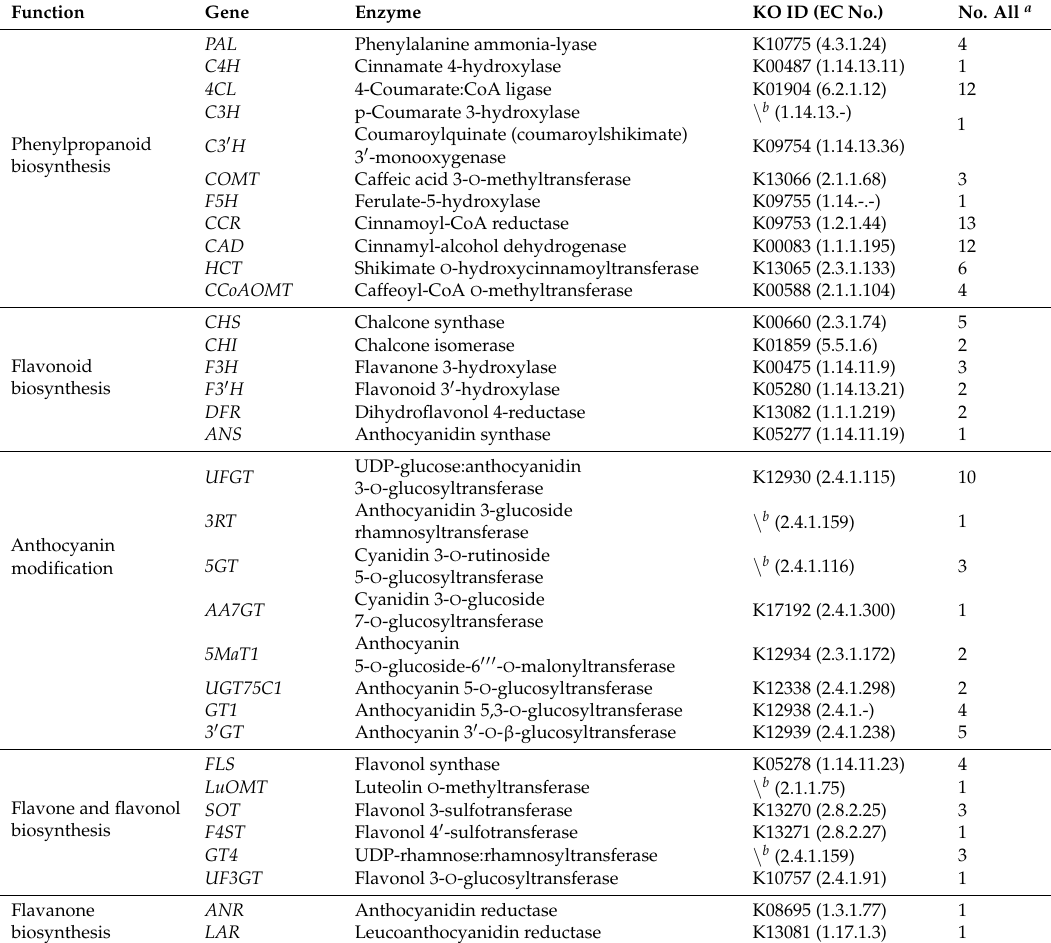
Table 1. Unigenes related to flavonoids metabolic pathway in tepals of Chinese narcissus. Function Gene Enzyme KO ID (EC No.) No. All